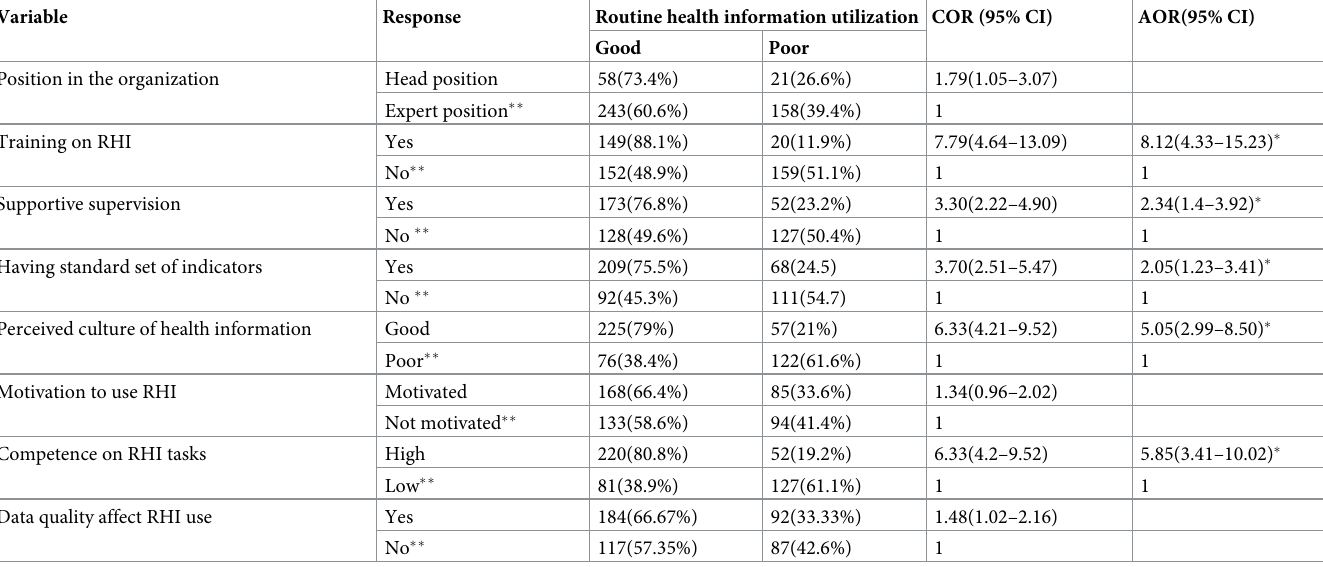
Table 4. Factors associated with routine health information utilization among health workers in Hadiya zone, SNNRP, 2019, n =